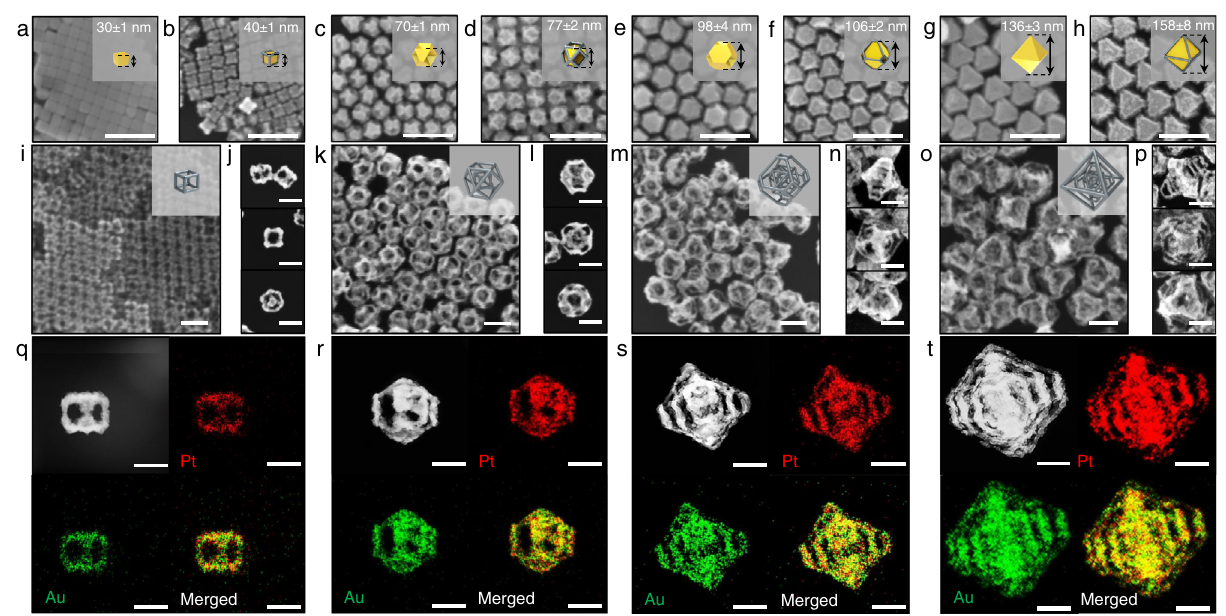
Fig.4|Morphologyevolutionfrom1 st to4 th nanoframes. SEMimagesof a 1 st -Au- C-NPs, b 1 st -Au@Pt-C-NPs, c 2 nd -Au-CO-NPs, d 2 nd -Au@Pt-CO-NPs, e 3 rd -Au-TO-NPs, f 3 rd -Au@Pt-TO-NPs, g 4 th -Au-O-NPs, and h 4 th -Au@Pt-O-NPs, scale bar = 200nm. i – p Low magni fi cation and zoomed-in SEM images viewed from <110>, <100>,